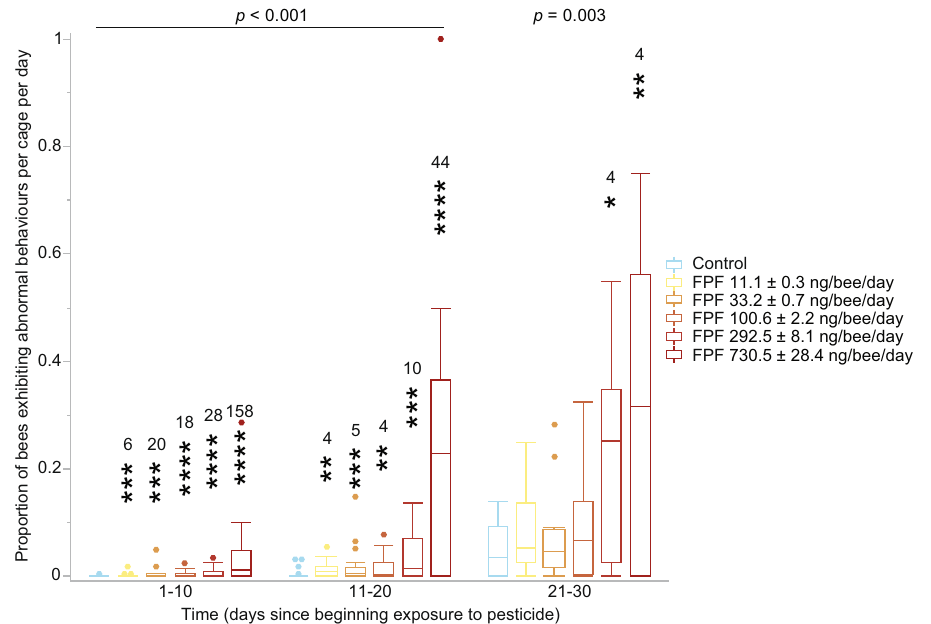
Fig. 3 Effects of fl upyradifurone (FPF) on the daily proportion of living bees exhibiting at least one abnormal behaviour per cage. We assessed the results in time blocks of 10 days to allow comparison between the standard 10-day risk assessment chronic test and longer term exposures 36 . We report the signi fi cance of the main effect of FPF treatment above each time period (Supplementary Table 10). Asterisks above the bars indicate signi fi cant differences between the respective FPF dose (reported in ng/bee/day, mean ± Standard Error of the Mean, SEM) and the controls (GLM DS ; n = 111; * p = 0.05, ** p = 0.01, *** p = 0.001, **** p = 0.0001; Supplementary Table 11). We report the effect sizes measured in fold-increase above each signi fi cant effect to facilitate interpretation given the low absolute values of the control treatment and the lower FPF doses (Supplementary Table 12). The box-plot reports the maximum (excluding outliers), the percentiles (75th, 50th, and 25th), the minimum (excluding outliers), and the outliers. Additional details are in Supplementary Tables 10,